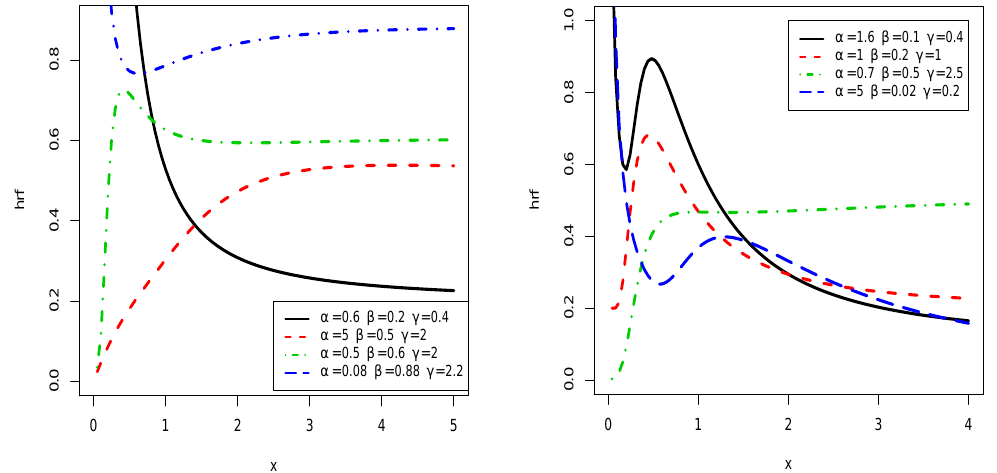
Figure 2. Plots for the hazard rate function (hrf) of the EMIEE distribution, for several values of the